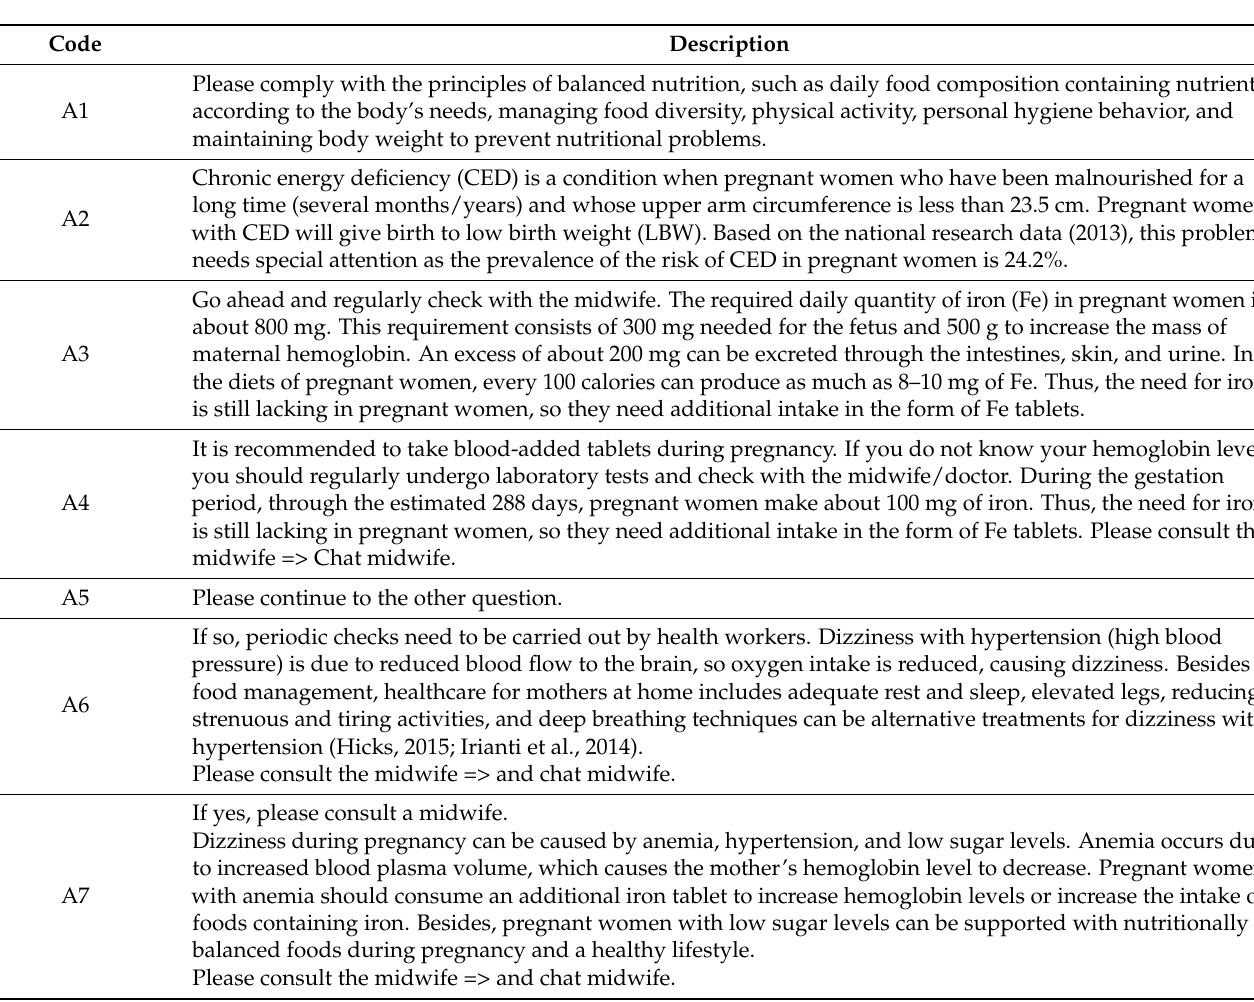
Table A3. The Answer List of Decision